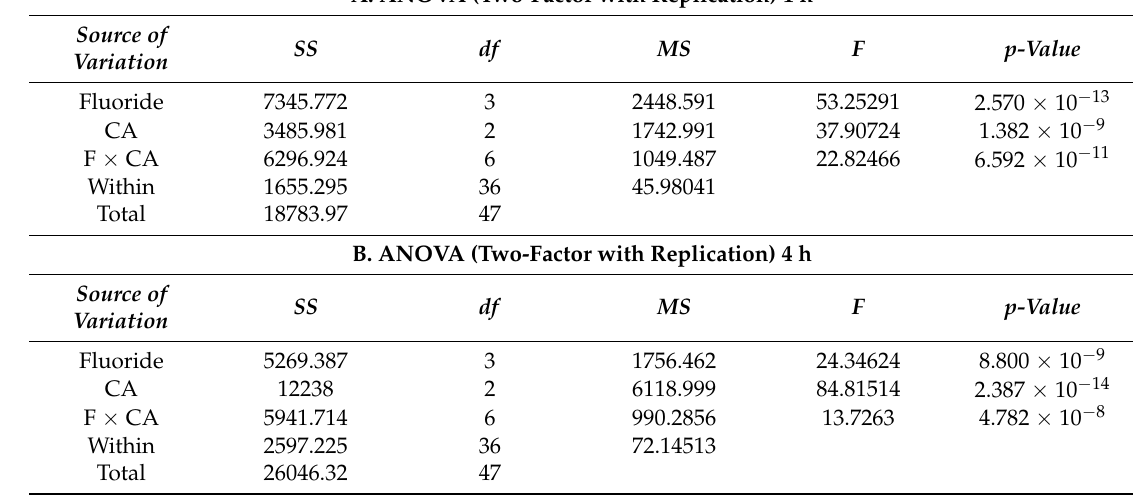
Table 3. ANOVA with